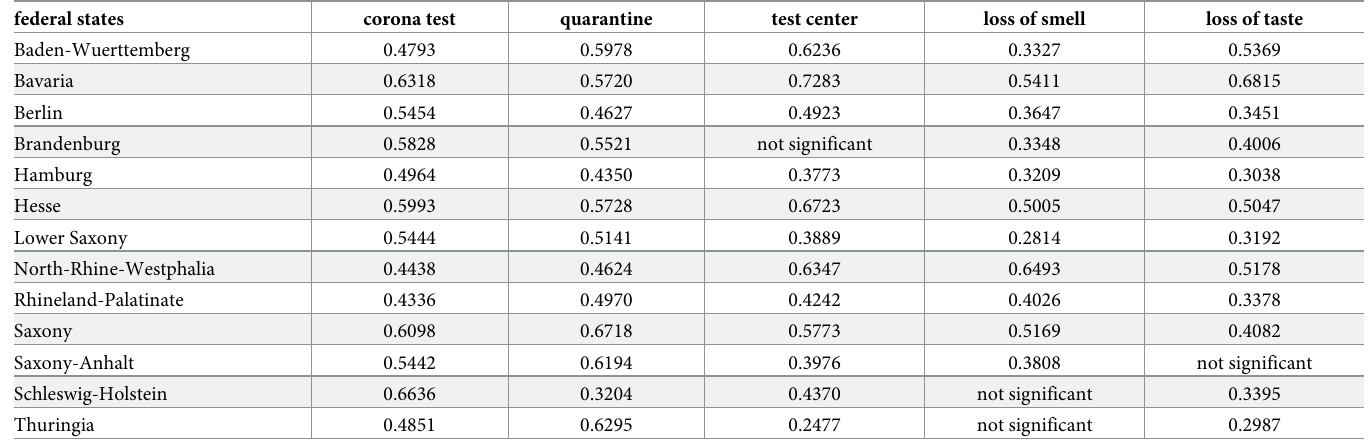
Table 2. Correlation of national case numbers with Google search queries per state (03/2020–05/2021). federal